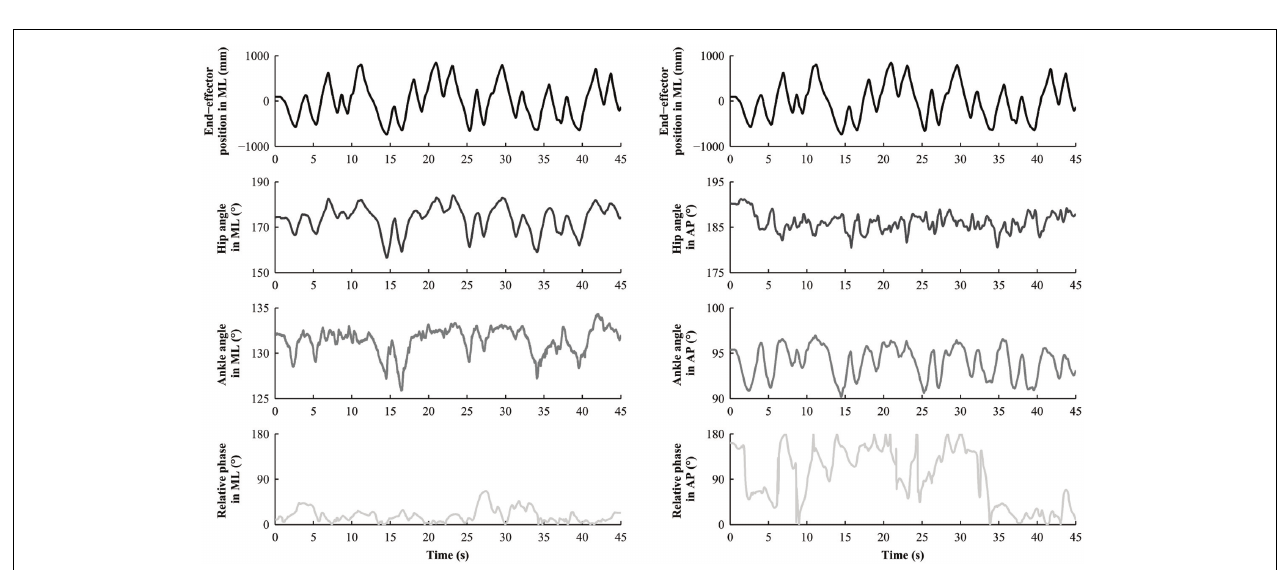
FIGURE 2 | Representative temporal series obtained in the Solo situation for one subject for the Large and Mono-frequency group (A); Large and Multi-frequency group (B); Small and Mono-frequency group (C) and Small and Multi-frequency group (D).